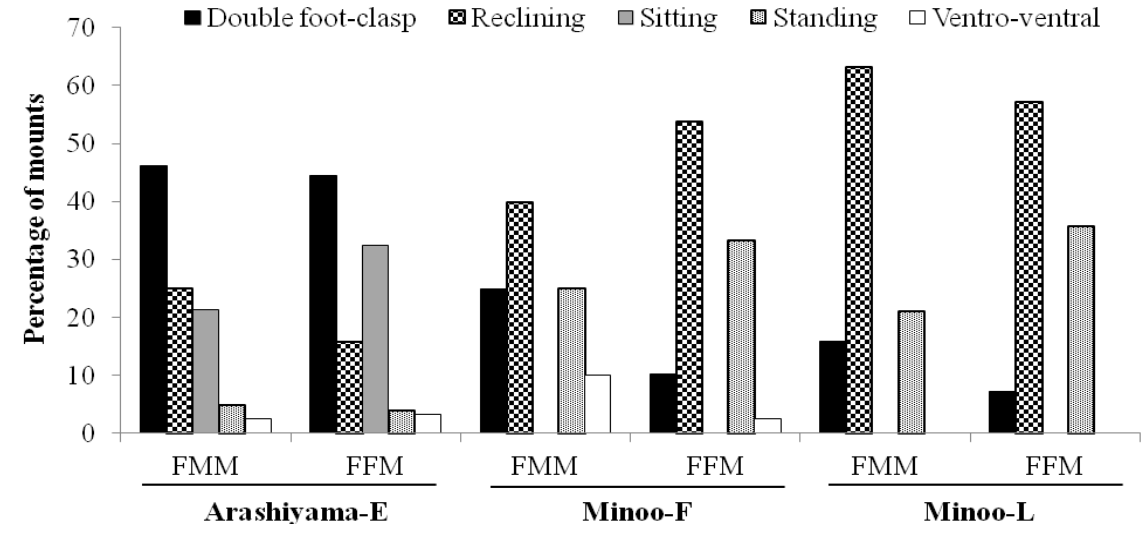
Figure 3. Inter-group differences in the percentage of mounting postures (FMM and FFM).